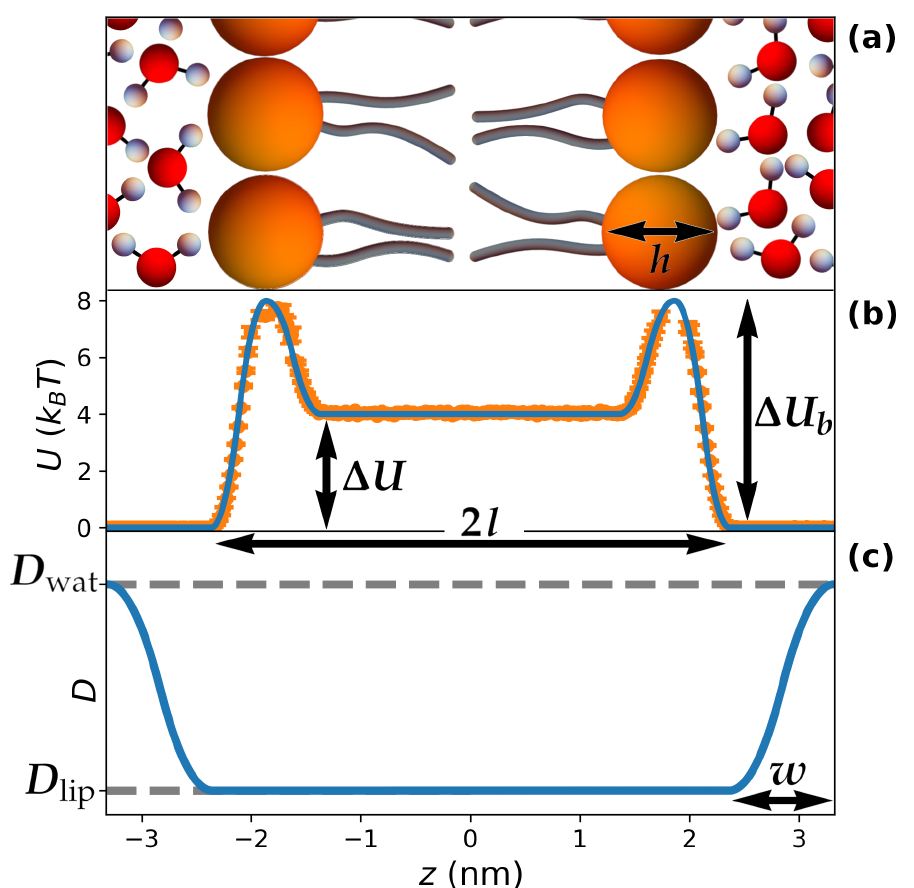
Figure 1. General features of the theoretical model. ( a ) sketch of a repeating unit in a lamellar mesophase and definition of the main parameters; molecules are not at scale; ( b ) representative peri- odic potential of mean force U ( z ) corresponding to the system in ( a ). In this case, U ( z ) corresponds to a hydrophilic molecule ( ∆ U > 0) with low affinity for the lipid heads ( ∆ U b > 0). The orange circles correspond to the free energy extracted from a control simulation to determine the optimal timestep, as described in the Methods; ( c ) representative periodic, position-dependent diffusion coefficient D ( z ) corresponding to the system in ( a ), smoothly changing from D lip within the lipid phase to D wat in the water phase far from the lipid/water